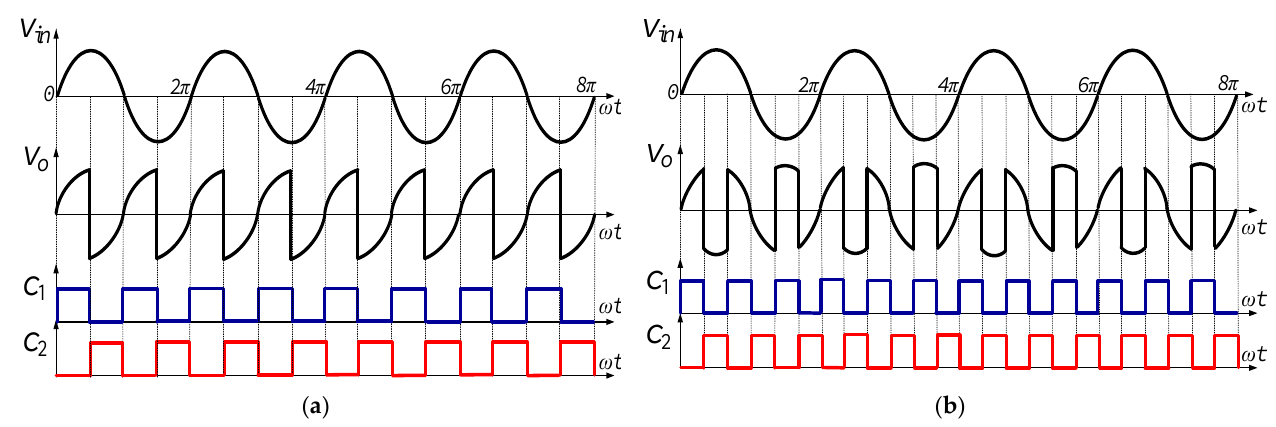
Figure 10. Output step-up frequency control with respect to input frequency: ( a ) two times; ( b ) three times. The control input c 1 is logic high once we require non-inverted input at the output while to invert the input, the control input c 2 has to be set to logic high. The nature of the instantaneous output voltage of Figure 10a,b with the reference of the input voltage is mathematically depicted in Equations (14) and (15) respectively. m